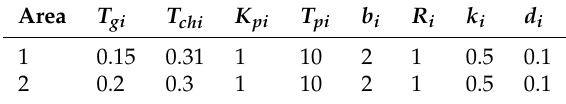
Table 1. Parameters of two-area LFC system.